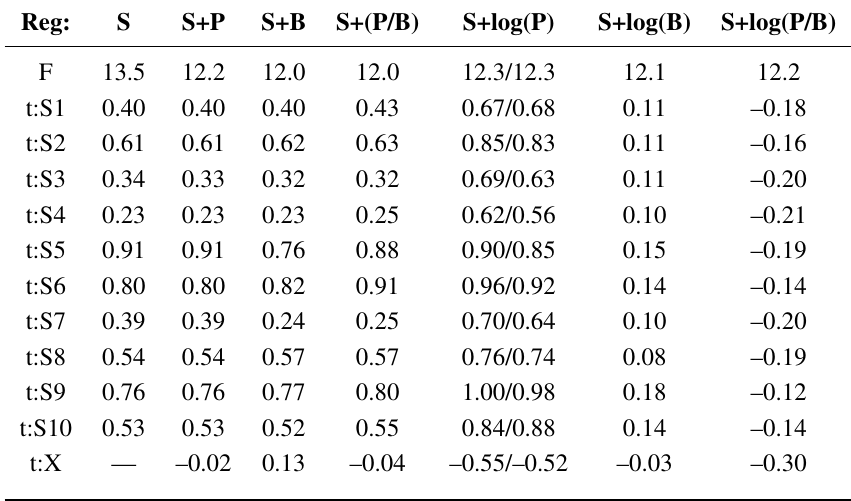
Table 3. Results for regressions (54) and (55) with the BICS-sector 10-factor model as the benchmark. The notations are the same as in Table 2, except that F = median F-statistic, and t = median t-value, where F-statistic and t-values are computed based on regressions (54) and (55) for each date, and the median is computed serially over all dates. The meaning of double entries in the S+log(P) column is the same as in Table